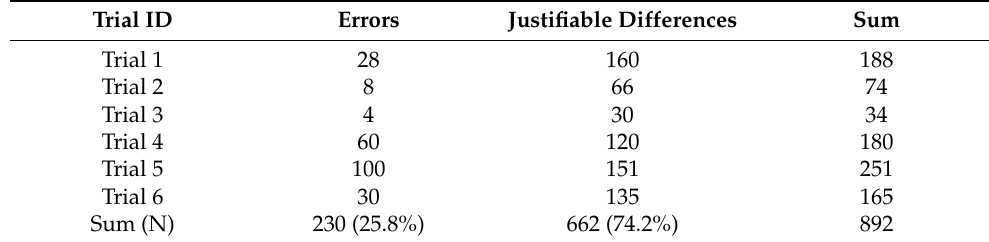
Table 4. Distribution of the types of